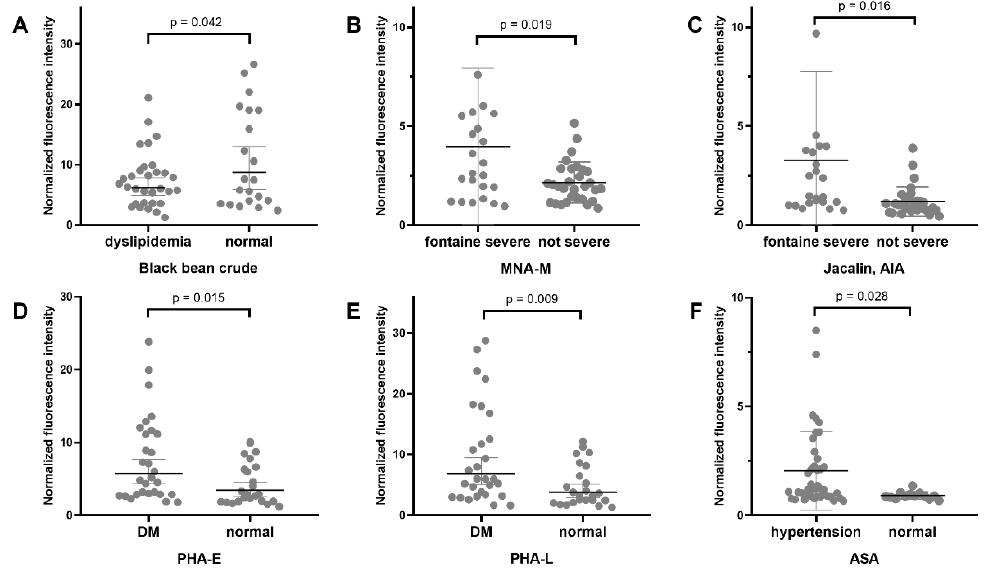
Figure 2. Positive results from lectin microarray for patients in different LEPAD subgroups. The following rules were used to identify significant differences for intra-disease group analysis: fold change[group1(S/N)/group2(S/N)] ≥ 1.75 or <0.571 and p -value < 0.05. DM, diabetes mellitus. Details of lectins and their binding glycan structures can be seen in the Supplementary Files. ( A ) Microarray result for black bean crude between LEPAD patients with or without dyslipidemia. ( B ) Microarray result for MNA-M between LEPAD patients with different Fontaine severity levels. ( C ) Microarray result for Jacalin between LEPAD patients with different Fontaine severity levels. ( D ) Microarray result for PHA-E between LEPAD patients with or without diabetes. ( E ) Microarray result for PHA-L between LEPAD patients with or without diabetes. ( F ) Microarray result for ASA between LEPAD patients with or without hypertension.